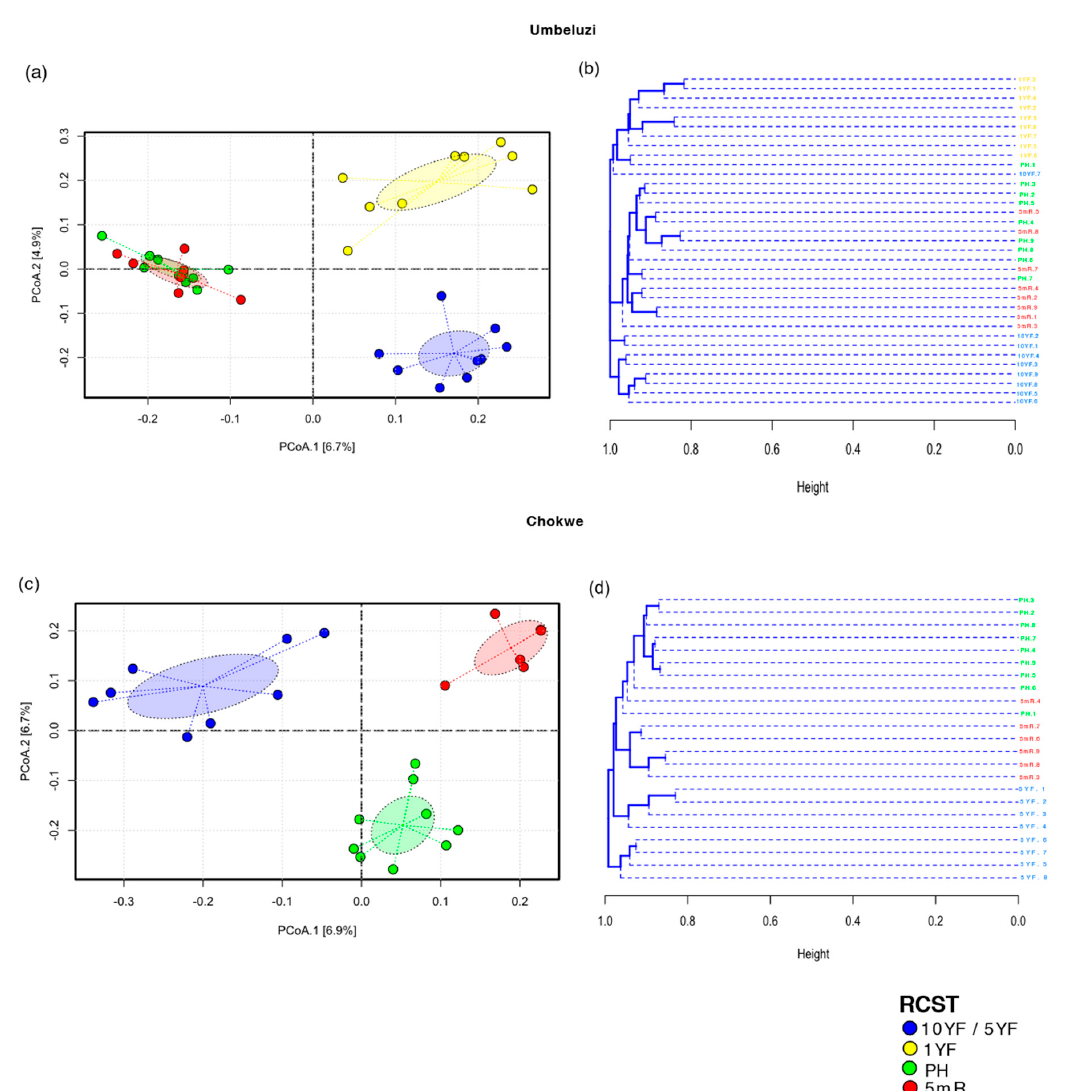
Figure 3. Multivariate differentiation of bacterial communities in rice cultivation statuses or time points (RCST). ( a , b ) Umbeluzi ( c , d ) Chokwe. Principal coordinate analysis (PCoA) plot and unweighted pair group method with arithmetic mean (UPGMA) cluster dendrogram are based on Bray-Curtis dissimilarities. Dotted lines in the PCoA plot show the distance of every sample to its group centroids in multivariate space, while ellipses show 95% confidence intervals (standard error) in multivariate space around group centroids. 10YF, ten years fallow; 5YF, five years fallow; 1YF, one-year fallow; PH, postharvest; 5mR, five months off-season time point. “10YF/5YF” denotes fallow fields in Umbeluzi or Chokwe, respectively. The differences in multivariate space among RCSTs in Umbeluzi and Chokwe are significant (PERMANOVA p < 0.05; see Table S1).